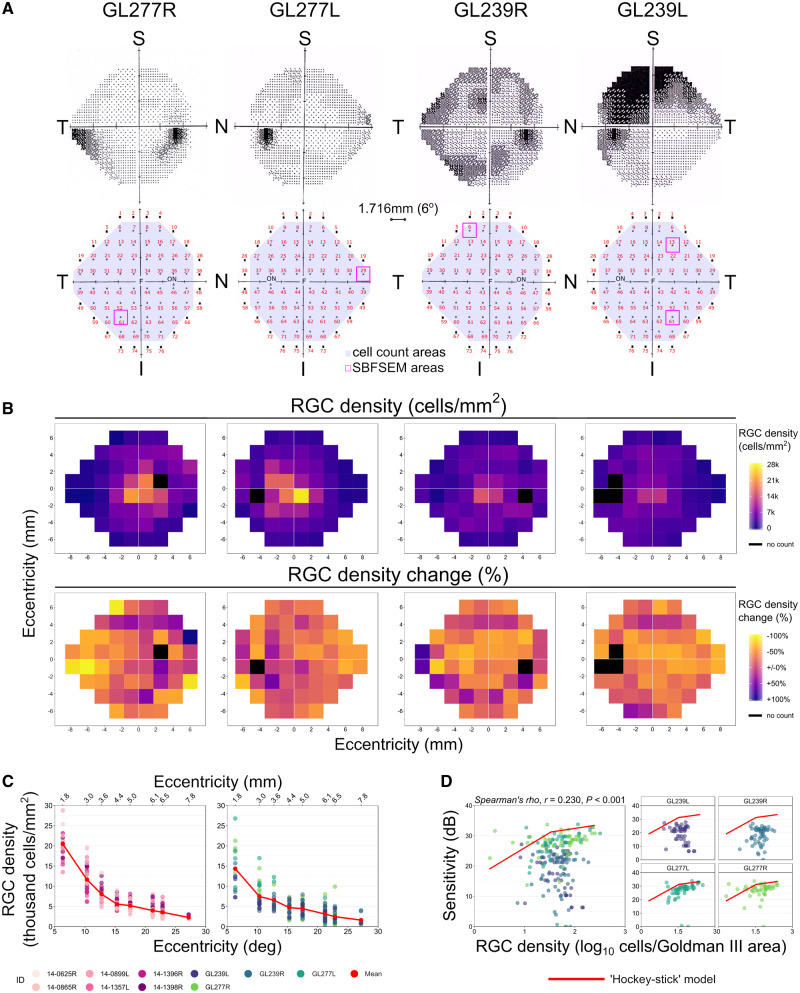

Retinal ganglion cell loss assessed in relation to visual field deficits. Human donor eyes from glaucoma donors (n = 4) complete with visual field tests conducted prior to death (A; upper row) were analysed in comparison to control donor eyes (n = 6). Whole retinas were imaged by two-photon microscopy, and cell counts made in regions of the retina corresponding to visual field test locations (A; lower row). Regions were numbered 1–72 beginning superior-temporally, with regions corresponding to visual field test locations highlighted (purple shading; n = 54 locations). Following imaging, 11 regions were dissected out and processed for SBFSEM (magenta boxes). (B) Retinal ganglion cell densities were estimated for each test location from z-stack counts within an en face area of 350 µm2 and expressed as cells/mm2. Density plots for each glaucomatous retina (B; upper row) with corresponding percentage change from average control density at each region (B; lower row). Region locations are inverted along the superior to inferior axis to correspond to the visual field plots (as the superior retina views the inferior visual field and vice versa). Retinal ganglion cell density change against eccentricity was plotted for control (C; left panel) and glaucoma eyes (C; right panel). The relationship between retinal ganglion cell density [expressed as log10 cells/area of the stimulus (Goldman III)] and visual sensitivity is plotted in D. There was no correlation when retinas were grouped as shown by linear regression (‘Spearman’s rho’, r = 0.23, P < 0.001; D). Individual retinas show high variation among eyes (D). The ‘hockey stick’ model fitted by Swanson et al. (2004) to a plot of normal visual field sensitivity, corrected to a 34-year old (Heijl et al., 1987) against normal retinal ganglion cell counts (Curcio and Allen, 1990), is superimposed on the data from the current study in D (red line). Individual retinas show a similar relationship when retinal ganglion cell density is high but a greater than expected drop-off in sensitivity when cell density is low. Retinal ganglion cell abbreviated to RGC in B–D. For A, F = fovea, ON = optic nerve; retinal orientation identified by N = nasal, I = inferior, S = superior, T = temporal. Retinal ganglion cell density scales through low (purple) to high (yellow) (B; upper row). Retinal ganglion cell density change scales through +100% of control average (purple) to −100% of control average (yellow) (B; lower row). Black regions in B represent regions around the optic nerve where cell counts were not taken.